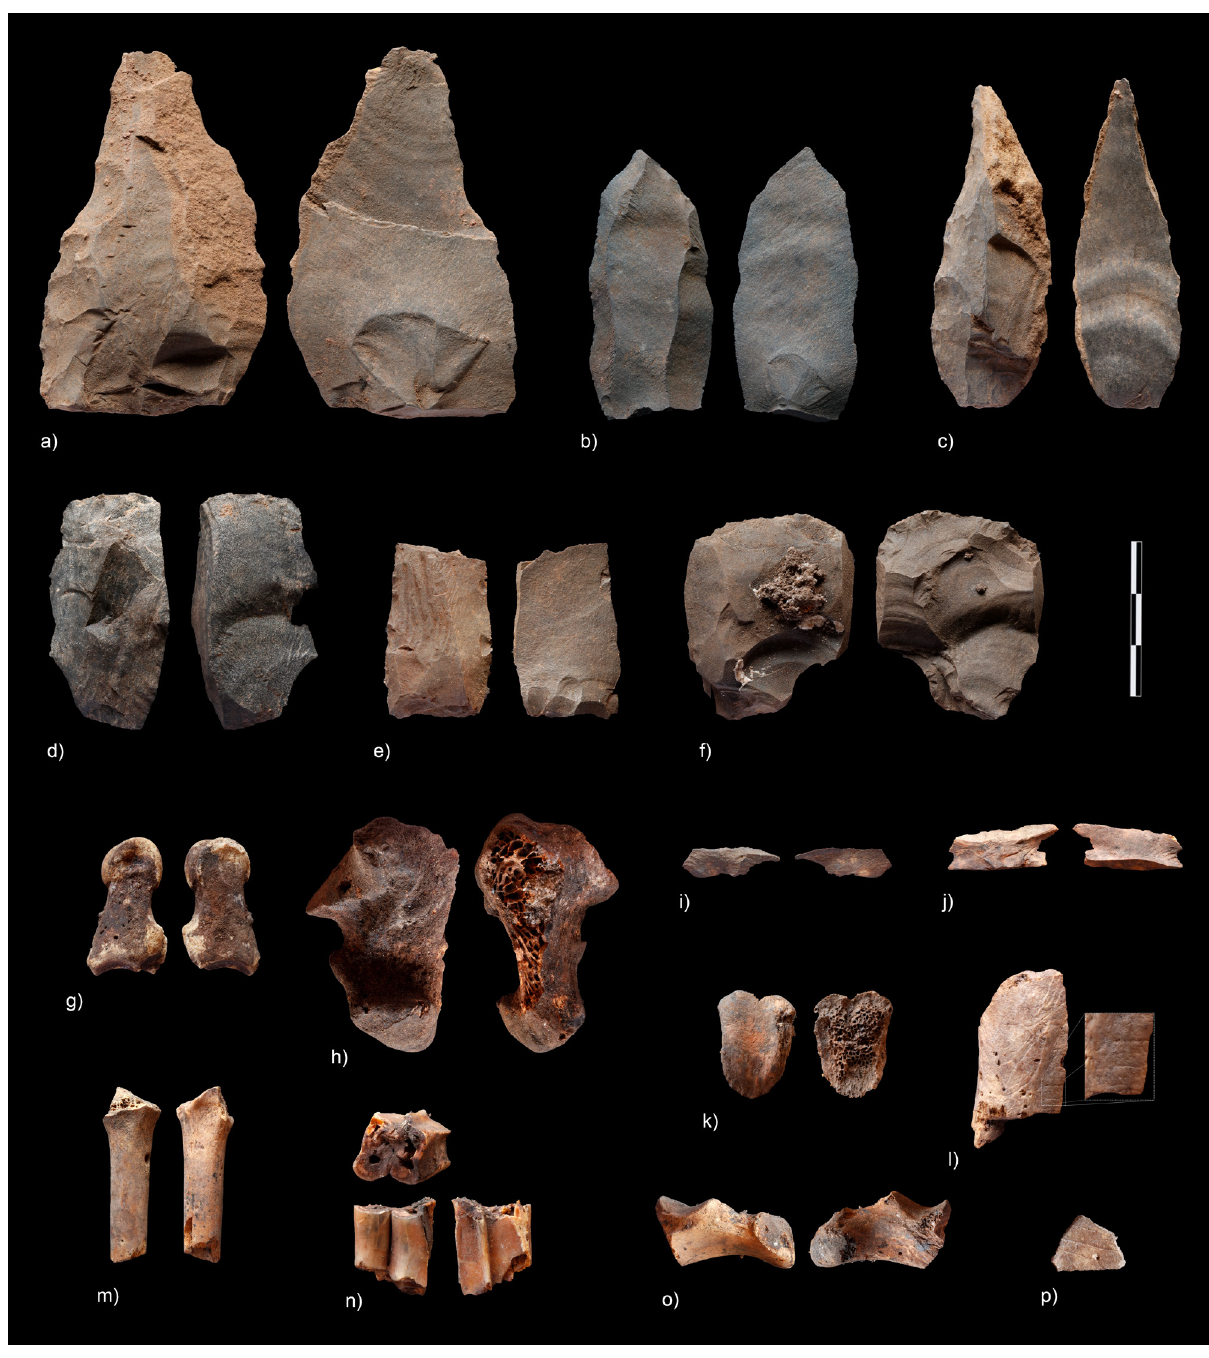
Figure 4: Artefacts from layer BIB in the northern section at Holley Shelter: (a–c) unifacial points, (d–f) splintered pieces, (g, h, k, m, n, o) identifiable faunal remains, (i, j) bone flakes, (l, p) bones with cutmarks. Photos by G. Bader. In the smaller trench at the bottom of the old Cramb excavation area, the first 10 cm of the deposits represent backfilling and disturbance over the past 60–70 years. The sediments below, however, are intact. Because we cannot yet correlate the layer system from the northern section with the Cramb area, we decided to use descriptive layer names in this trench which will be replaced by alphabetical names once we can connect both trenches. The first intact layer in the Cramb area is yellow brown ash (YBA), a hearth feature containing substantial amounts of hornfels artefacts, faunal and botanical remains and frequent charcoal. The top surface of YBA lies approximately 1.20 m below the top surface of AVA in the northern section. Underneath YBA follow layers grey yellow speckled (GYS), grey white speckled (GWS) and grey brown ash (GBA). GWS also features well-preserved, small hearths. Stone artefacts in those